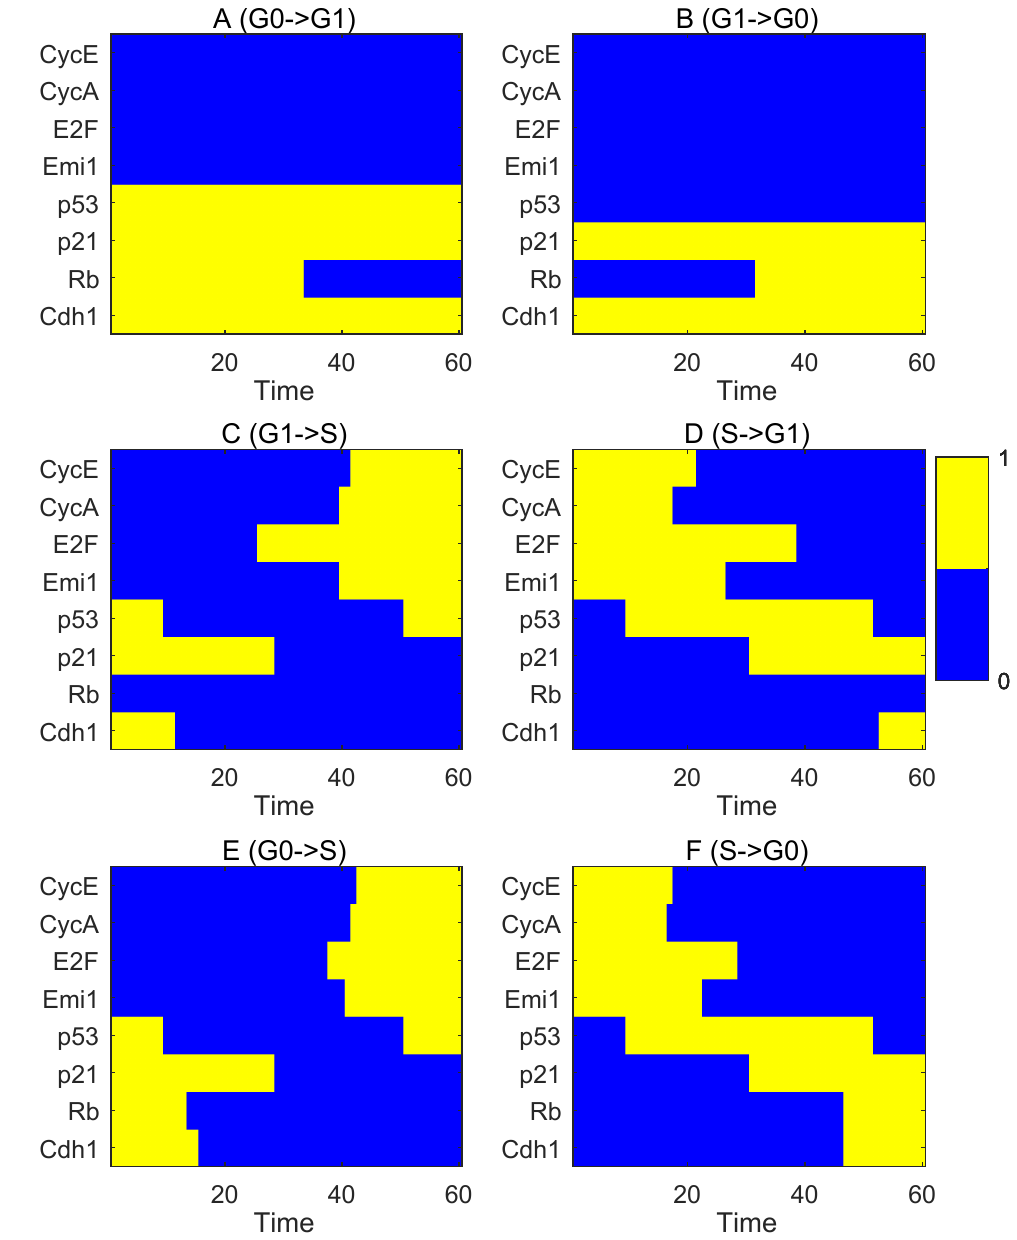
Figure 2. The kinetic transition path for each state transition. ( A ) The transition path from G0 to G1. ( B ) The transition path from G1 to G0. ( C ) The transition path from G1 to S. ( D ) The transition path from S to G1. ( E ) The transition path from G0 to S. ( F ) The transition path from S to G0. The blue bars denote inactivated states, and the yellow bars denote activated states. The X axis represents the time of cell state transition and the Y axis represent different